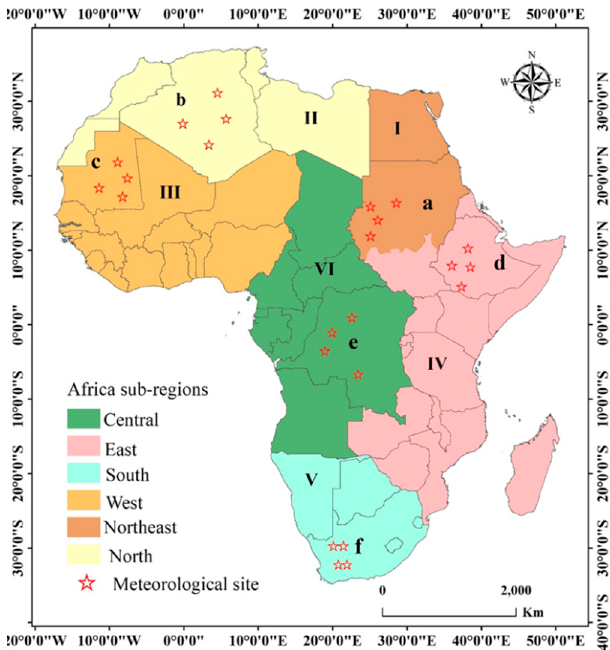
Figure 1. The study area is divided into six subregions (I, II, III, IV, V, VI), and the red stars represent the meteorological sites used for validation in six critical countries ( a : Sudan, b : Algeria, c : Mauritania d : Ethiopia, e : Congo, and f : South Africa).